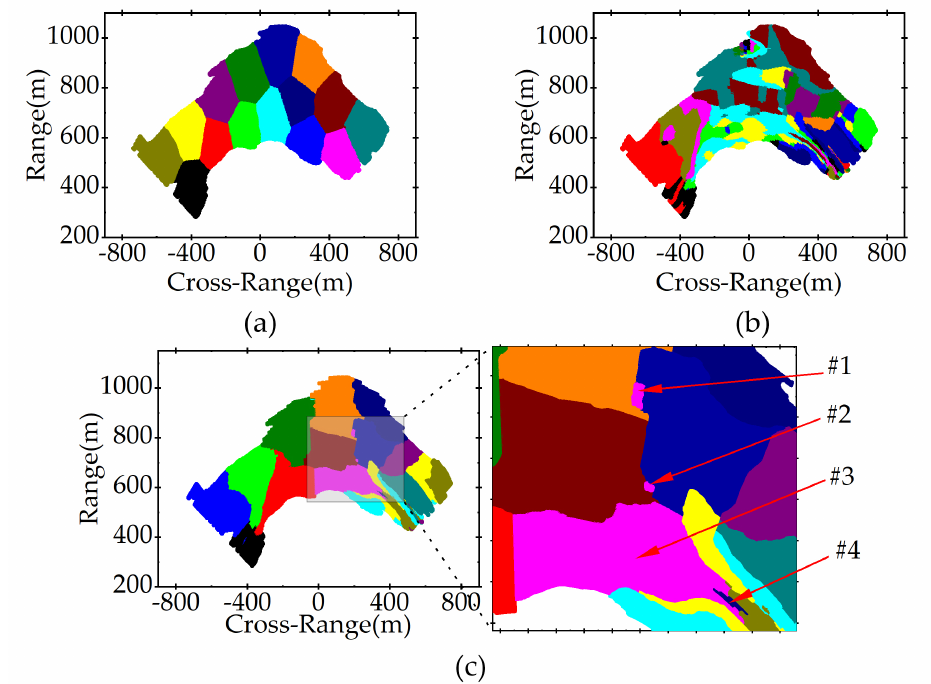
Figure 9. Clustering partition results using ( a ) position coordinate, ( b ) normal vector, and ( c ) spatially constrained normal vector. Different colors in the figures represent different